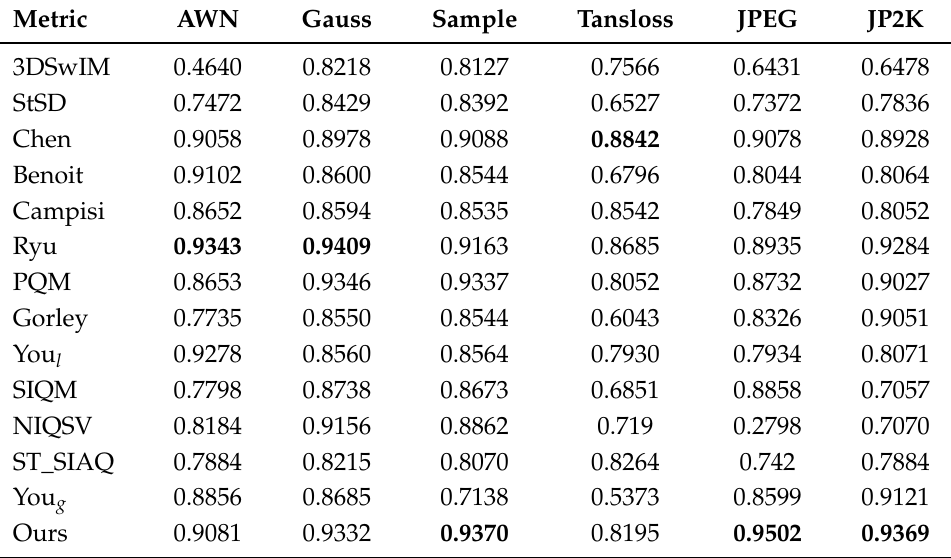
Table 4. Comparison of the proposed and the compared 3D image quality assessment (3D-IQA) metrics on individual distortion types in terms of PLCC. The best results are highlighted in